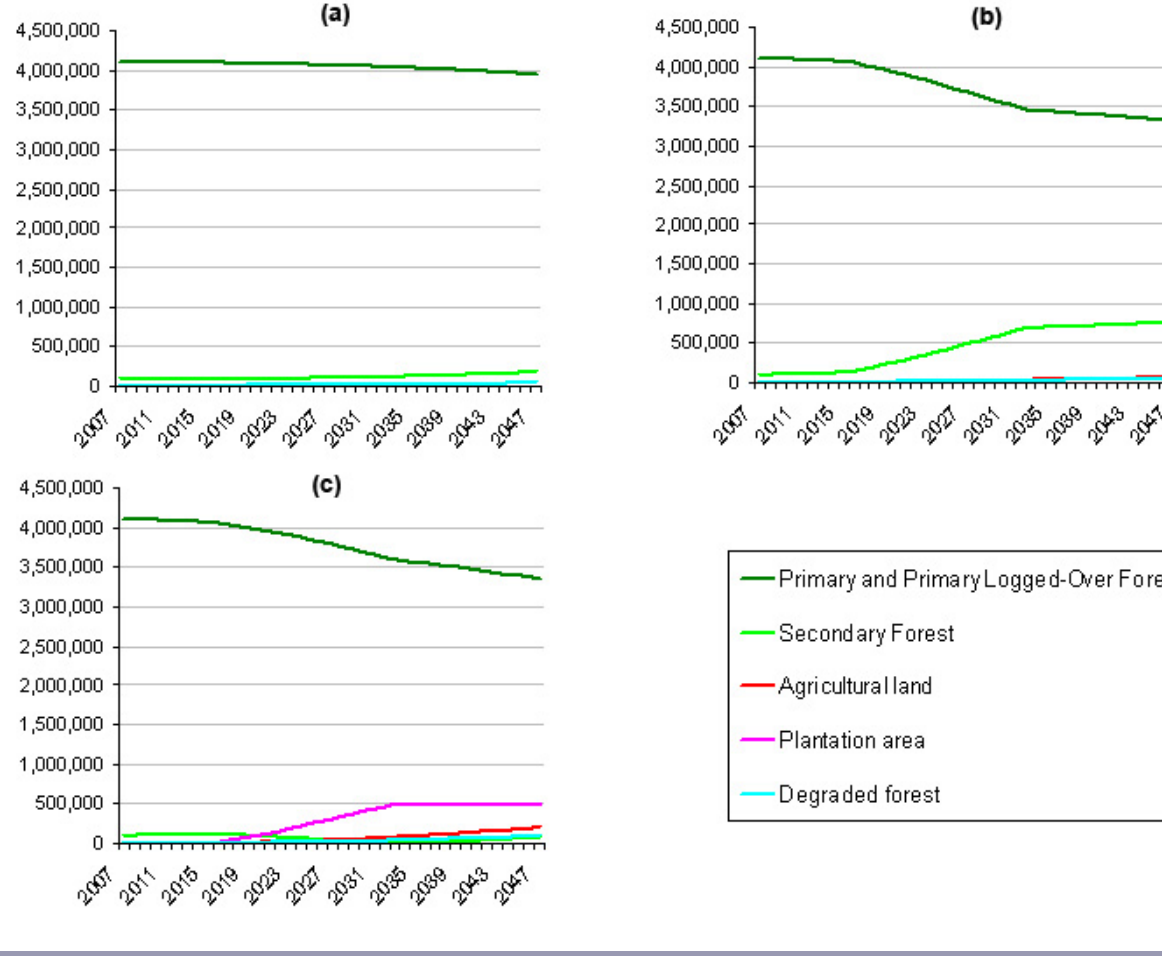
Fig. 3. A 40-year simulation of land cover in Malinau district: (a) Scenario 1, No clearing permit given out; (b) Scenario 2, Forest clearing without oil palm planted; (c) Scenario 4, Plantation development (high